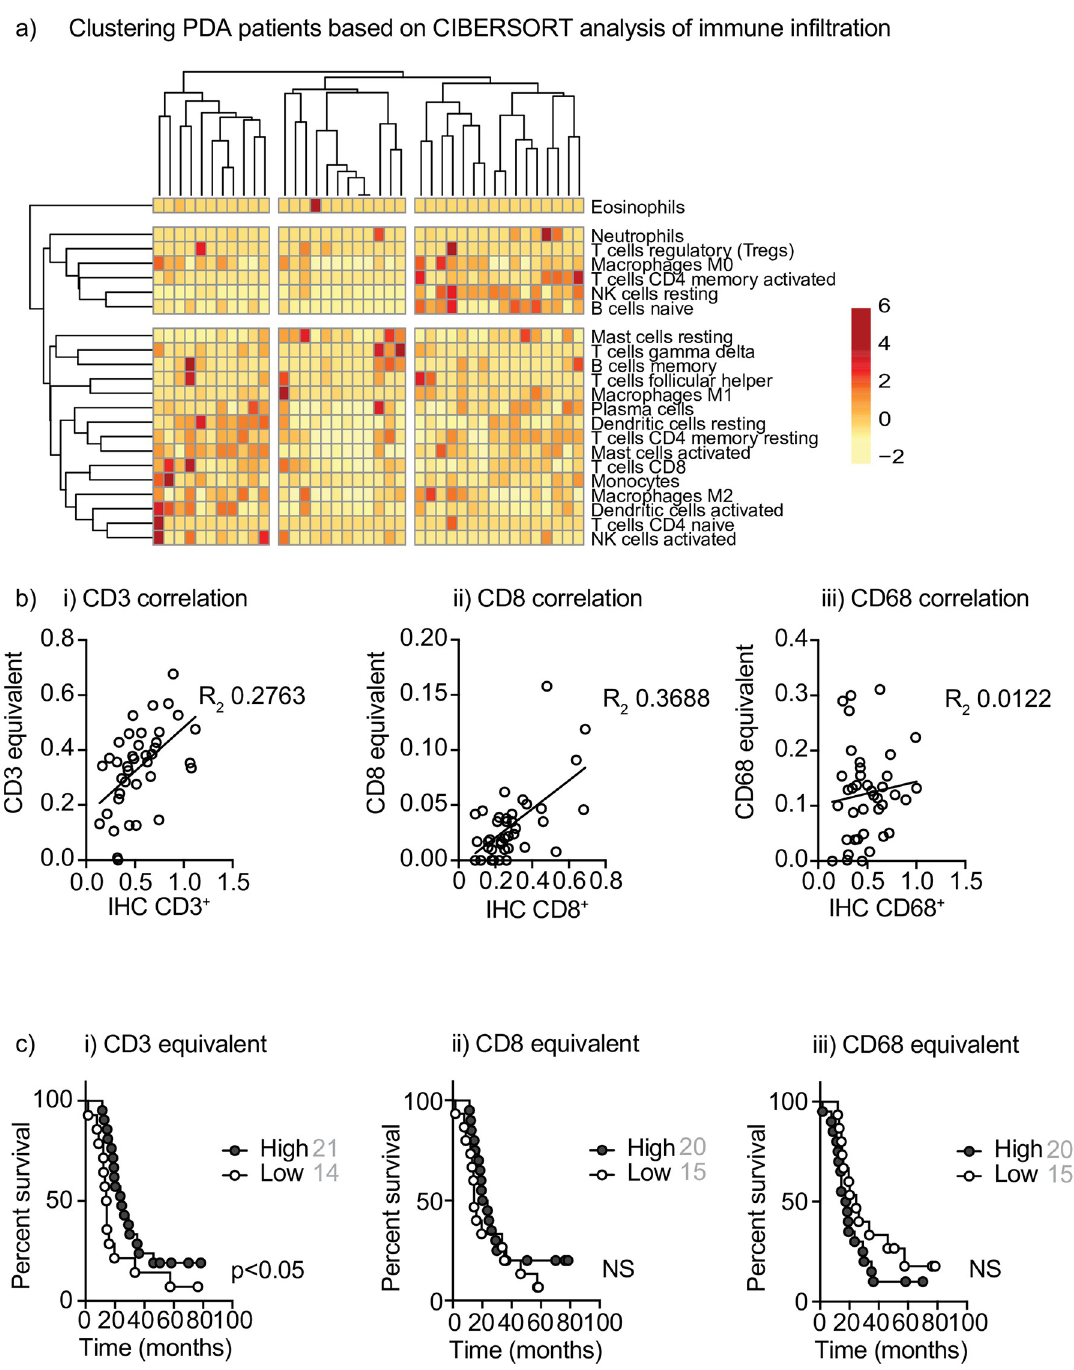
Fig 2. Evaluation of CIBERSORT analysis of immune infiltration. a) Clustering of immune populations inferred using CIBERSORT analysis of RNASeq of PDA patients. Rows are centered; unit variance scaling is applied to rows. Both rows and columns are clustered using correlation distance and average linkage. 22 rows, 39 columns. b) The immune infiltrate score of all i) CD3 + , ii) CD8 + , and iii) CD68 + equivalent cell populations (Table 2) determined by CIBERSORT compared to quantitative IHC from the same patient. Each symbol represents one patient. c) Overall survival of patients with high versus low infiltrates of i) CD3 + , ii) CD8 + , and iii) CD68 + equivalent cell populations (Table 2) determined by median CIBERSORT infiltration. NS = not significant.